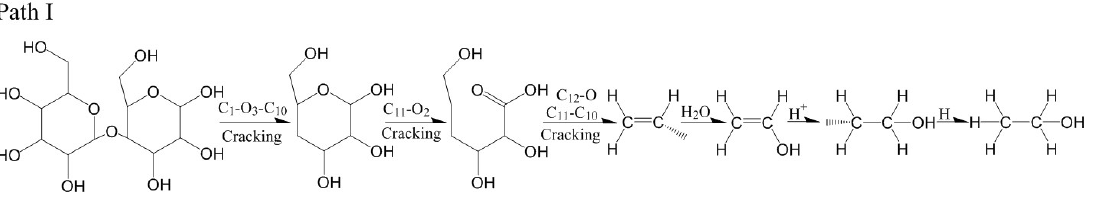
Figure 12. Relevant generation path I of ethanol at 2600 K.